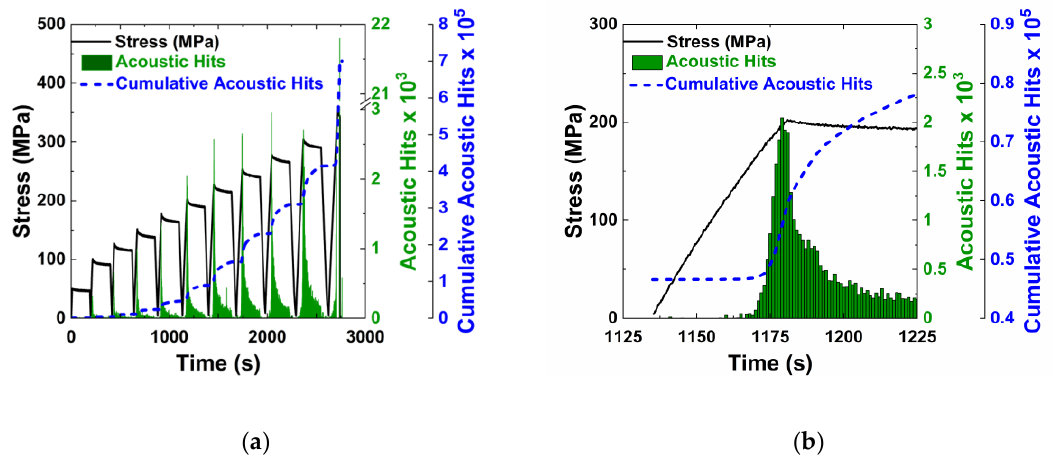
Figure 7. A control specimen without carbon nanotubes tested to failure under progressively increasing cyclic loading. ( a ) Stress and acoustic activity throughout the entire cyclic test, and ( b ) an examination of acoustic activity that occurs during the sixth loading cycle.